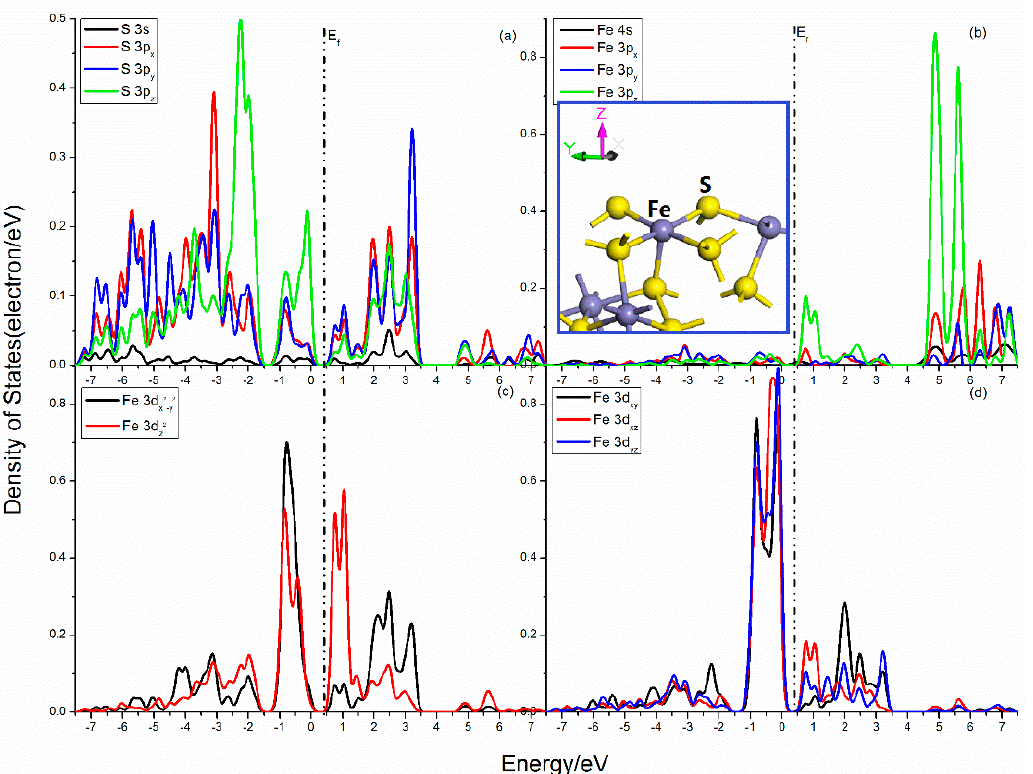
Figure 2. Projected DOSs of S and Fe atoms of pyrite (100) surface: ( a ) S 3s, 3p x , 3p y and 3p z states; ( b ) Fe 4s, 3p x , 3p y and 3p z states; ( c ) Fe 3d x2 –y2 and 3d z2 states; ( d ) Fe 3d xy , 3d xz and 3d yz states.